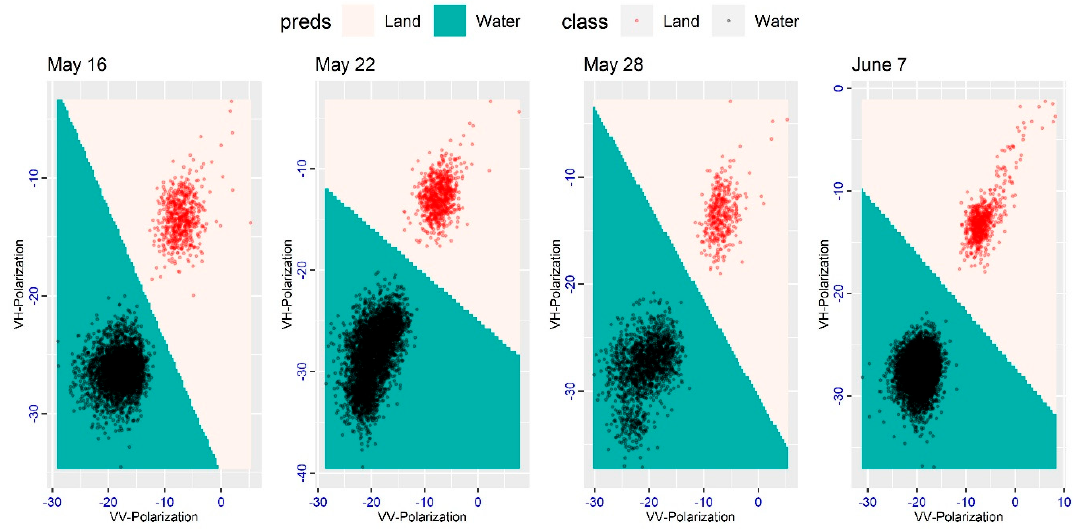
Figure A1. The training points and classification margin of support vector machine (SVM) in a two-dimensional plane.